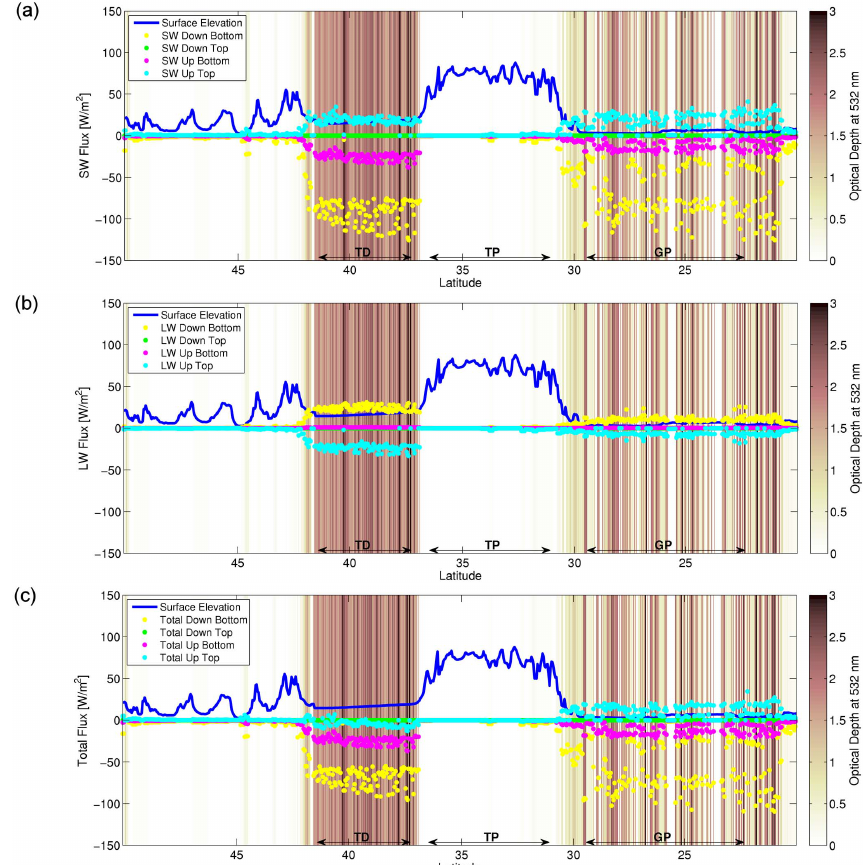
Fig. 5. Anomalies in (a) SW, (b) LW, and (c) Total (SW+LW) fluxes induced by aerosols at the top (50kma.m.s.l.) and bottom (0kma.m.s.l.) of the modeled atmosphere in both upward and downward directions. The background shading indicates the AOD at 532 nm as measured by CALIPSO. MODIS surface albedo values and CALIPSO aerosol distributions are used as input. Approximate extensions of the TD, TP, and GP regions are marked on the